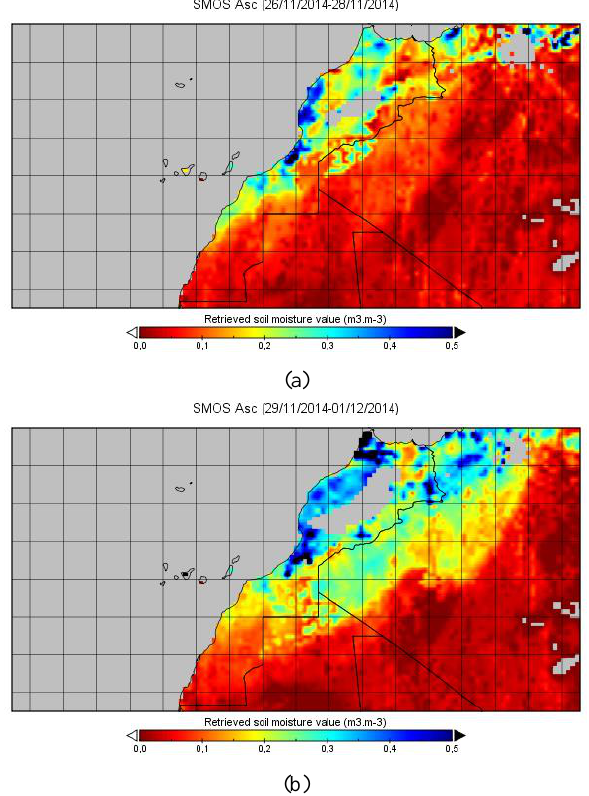
Figure 6. SM maps during the second period of rain on 27 and